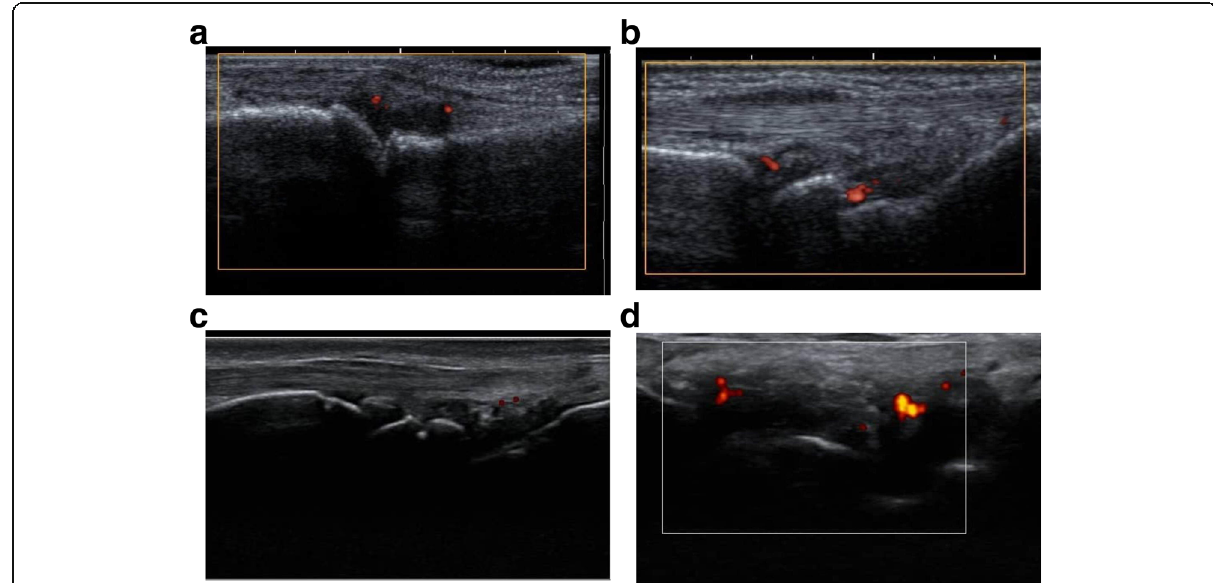
Fig. 2 Relation between the gray scale ultrasound scan and Doppler flow signal with Sema3A and 14-3-3 η protein levels. a Longitudinal scan of the metacarpophalangeal joints showing synovitis grade 3 with Doppler signal grade1 (low-disease activity score). The 14-3-3 η protein level showed an increase up to 0.49 ng/ml (controls 0.14 ng/ml) and Sema3A level showed mild decrease 5.1 ng/ml (controls 6.5 ng/ml). b Longitudinal scan of the radiocarpal and intercarpal joints showing synovitis grade 2 Doppler signal grade 1 (low-disease activity score). Serum 14-3-3 η protein level is 0.46 ng/ml and Sema3A level is 4.1 ng/ml. c Longitudinal scan of the intercarpal joints showing erosion and grade 2 synovitis and grade 1 Doppler signal (low-disease activity score with erosions). The14-3-3 η protein level is 0.5 ng/ml, and Sema3A level is 5.9 ng/ ml. d Longitudinal scan of the wrist showing grade 3 synovitis and grade 2 Doppler signal with effusion (moderate disease activity score). The 14- 3-3 η protein level is 0.61 ng/ml, and Sema3A level is 3.5